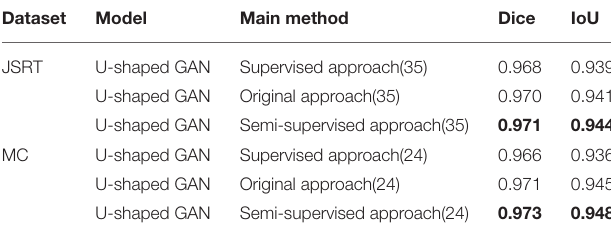
TABLE 6 | Comparison of U-shaped GAN with different training